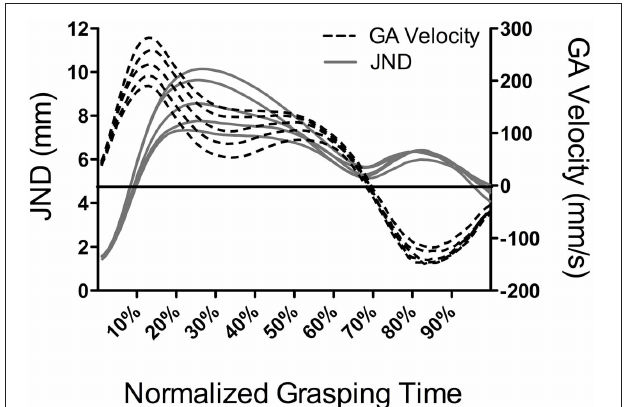
FIGURE 1 | Results from Holmes et al. (2011) showing JND magnitudes (mm: solid lines and left ordinate) and grip aperture (GA) velocities (mm/s: dotted lines and right ordinate) as function of object size (20, 30, 40, 50, and 60mm) at percentile increments of normalized grasping time. The horizontal line represents the zero crossing for aperture velocity. For ease of presentation, we did not include different symbols or line weightings to distinguish the different object sizes. However, the figure clearly depicts an increase in JNDs and GA velocities with increasing object size from approximately 10 through 50% of grasping time. During the later stages of aperture shaping, JNDs, and GA velocities do not reliably scale to object